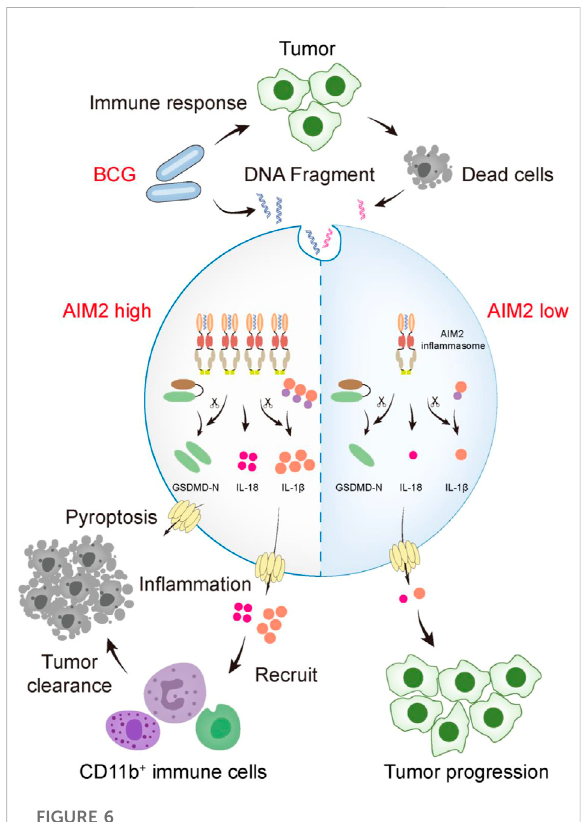
FIGURE 6 A schematic model that AIM2 in fl ammasome promotes the sensitivity of BCG therapy in BLCA. During intravesical BCG instillation of mouse bladders, the DNA fragments of BCG and deadtumorcellsgainaccesstothecytosolandaresensedby AIM2. Overexpressed AIM2 assembles more